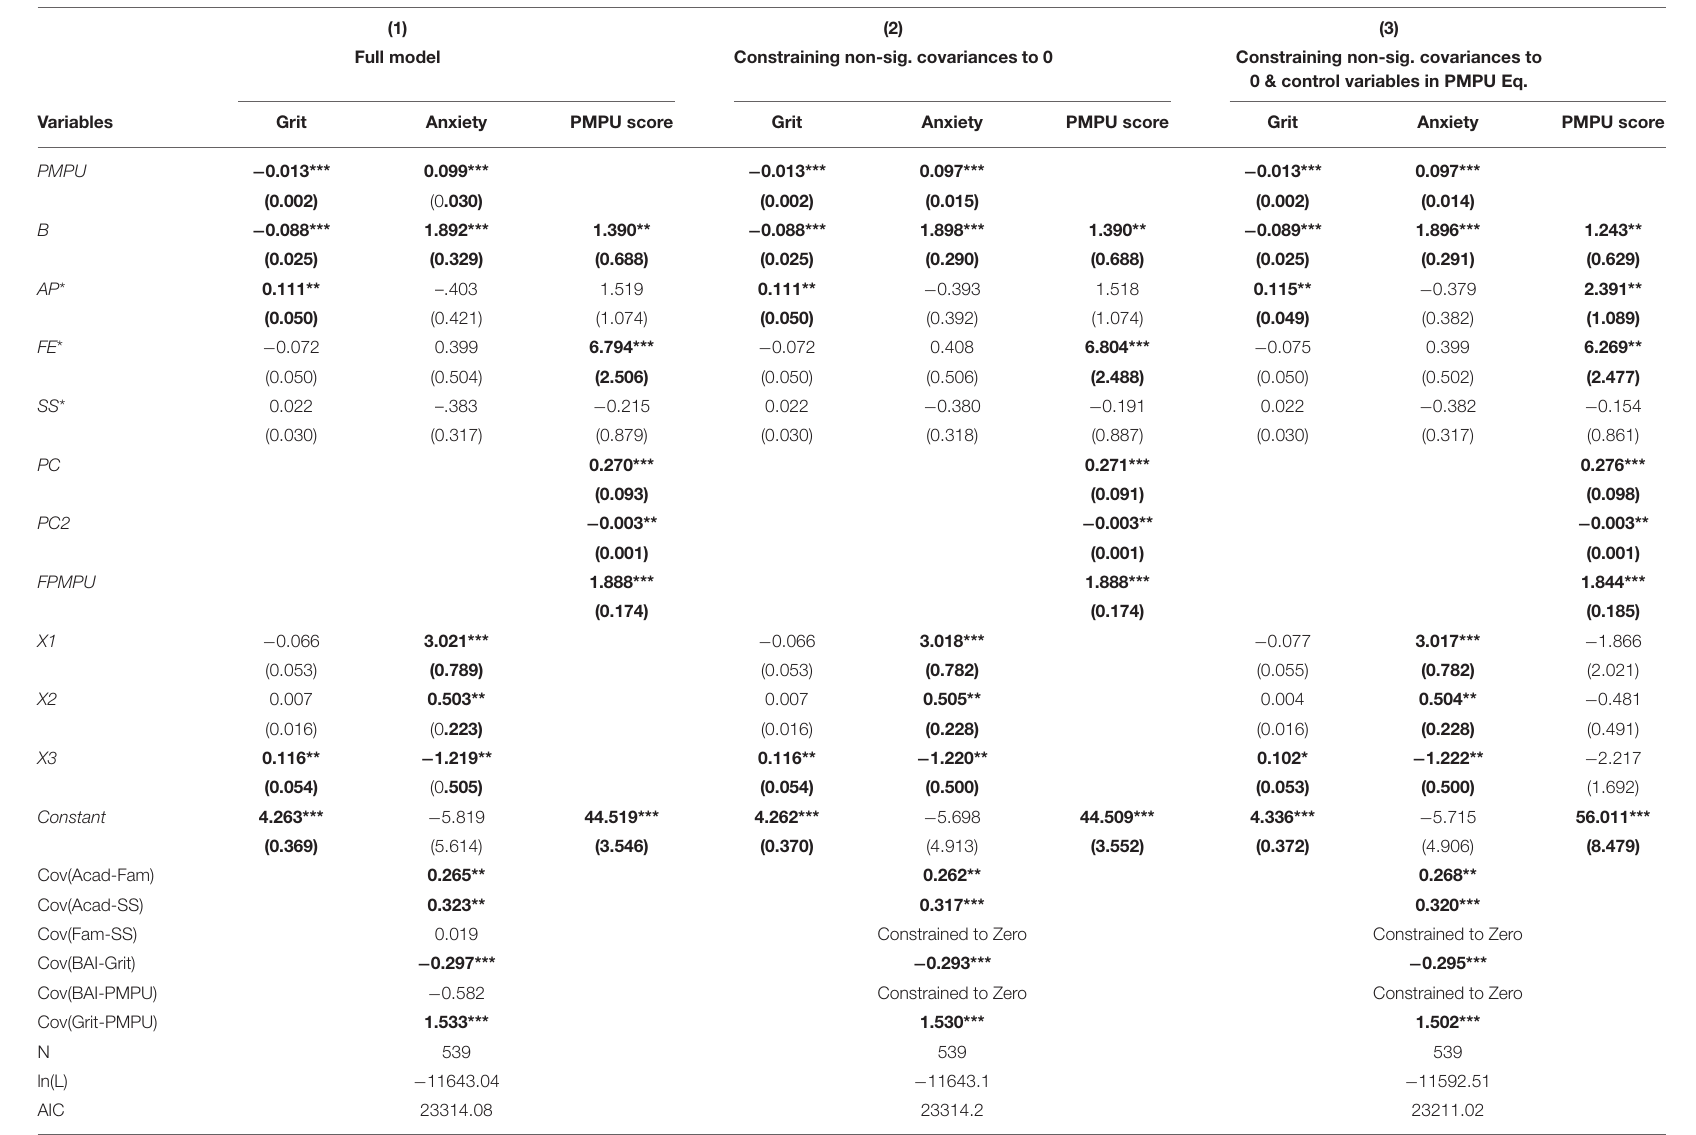
TABLE 3 | Results of generalized linear estimation for structural model of adolescent life influences on